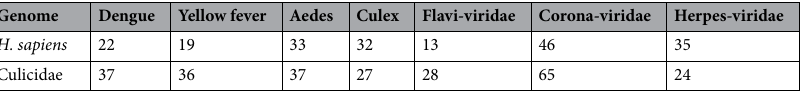
Table 4. Comparison of flavivirus heatmaps with heatmaps from Homo sapiens and Culicidae. The number of differences in third nucleotide bias (color, not magnitude) between heatmaps for specific flavivirus genomes is shown. Heatmaps from three viral families (Flaviviridae, Coronaviridae and Herpesviridae) are also compared to the Homo sapiens and Culicidae